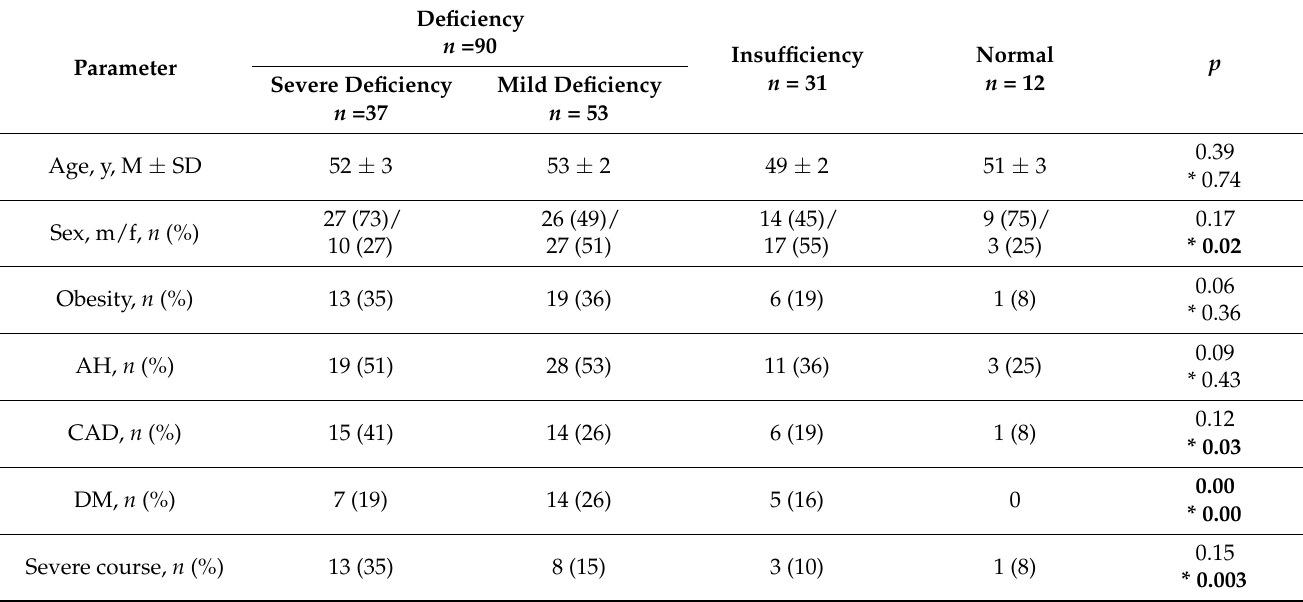
Table 2. Vitamin D status in 133 COVID-19